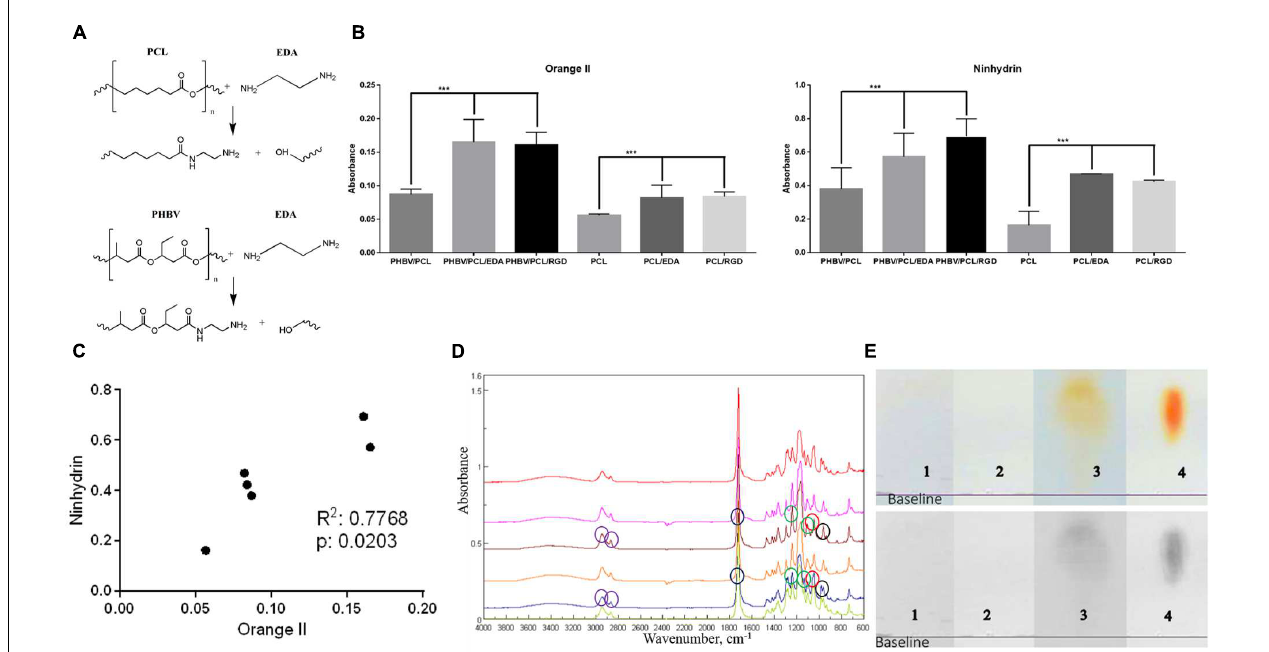
FIGURE 2 | Modification of PHBV/PCL and PCL vascular grafts with RGD peptides. (A) Aminolysis reaction scheme between EDA, PHBV, and PCL monomers. (B) Orange II staining and ninhydrin test demonstrated increased amino group presence in PHBV/PCL and PCL grafts with EDA or RGD peptides compared to those without, data are represented as mean with standard deviation, ∗∗∗ P < 0.001, two-tailed Student’s t -test. (C) Concordance test revealed a strong correlation between Orange II and ninhydrin assays for PHBV/PCL and PCL grafts with and without EDA treatment. (D) Fourier transform infrared spectroscopy showed the intensified signal from N–H stretching (around 960 cm − 1 , black circles) and the increase in amino residues in PHBV/PCL and PCL grafts with RGD peptides (brown and blue graphs, respectively). Peak around 1045 cm − 1 (red circles) corresponds to Si-O-Si stretching, peaks around 1172 and 1240 cm − 1 (green circles) correspond to C–O ester stretching, peak around 1720 cm − 1 (blue circles) corresponds to C = O aliphatic ester stretching, and peaks around 2865 and 2941 cm − 1 (violet circles) correspond to C–H asymmetric alkyl stretching. (E) Thin layer chromatography (TLC) spots after analyzing hydrolysed (1) PHBV/PCL, (2) PHBV/PCL/EDA, (3) PHBV/PCL/RGD, and (4) arginine and aspartic acid mixture on chromatographic silica to show the peptide content only in the RGD modified sample.